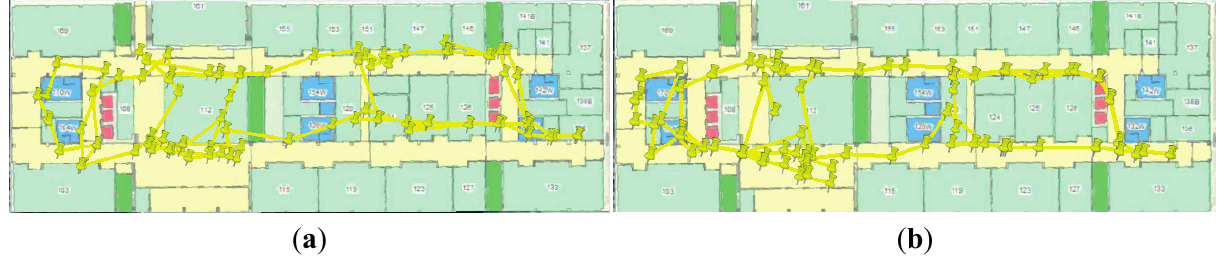
Figure 10. WiFi fingerprinting result using proposed DB ( a ) and that using reference DB ( b